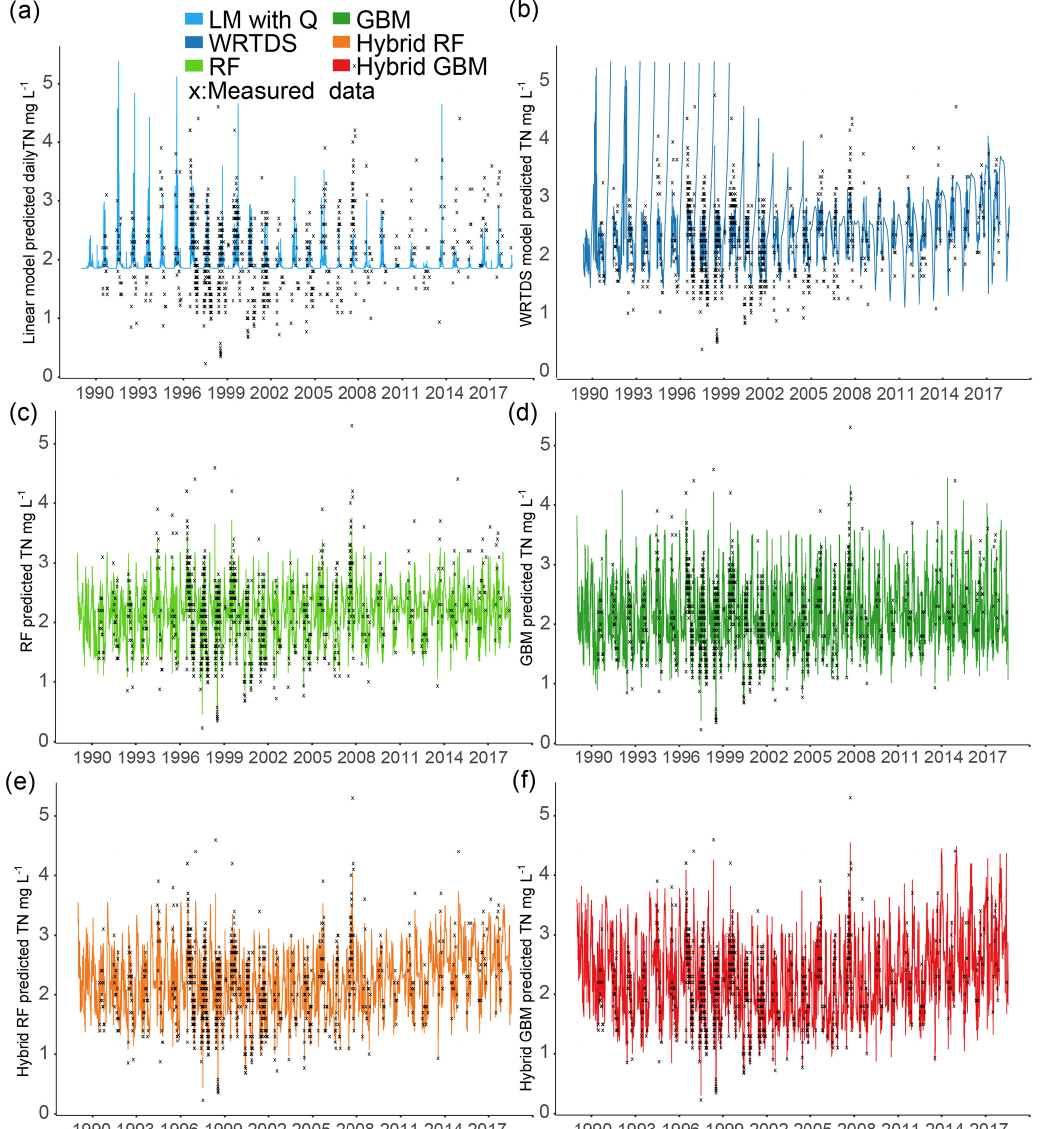
Figure 4. Daily TN generated by the six models for Ellen